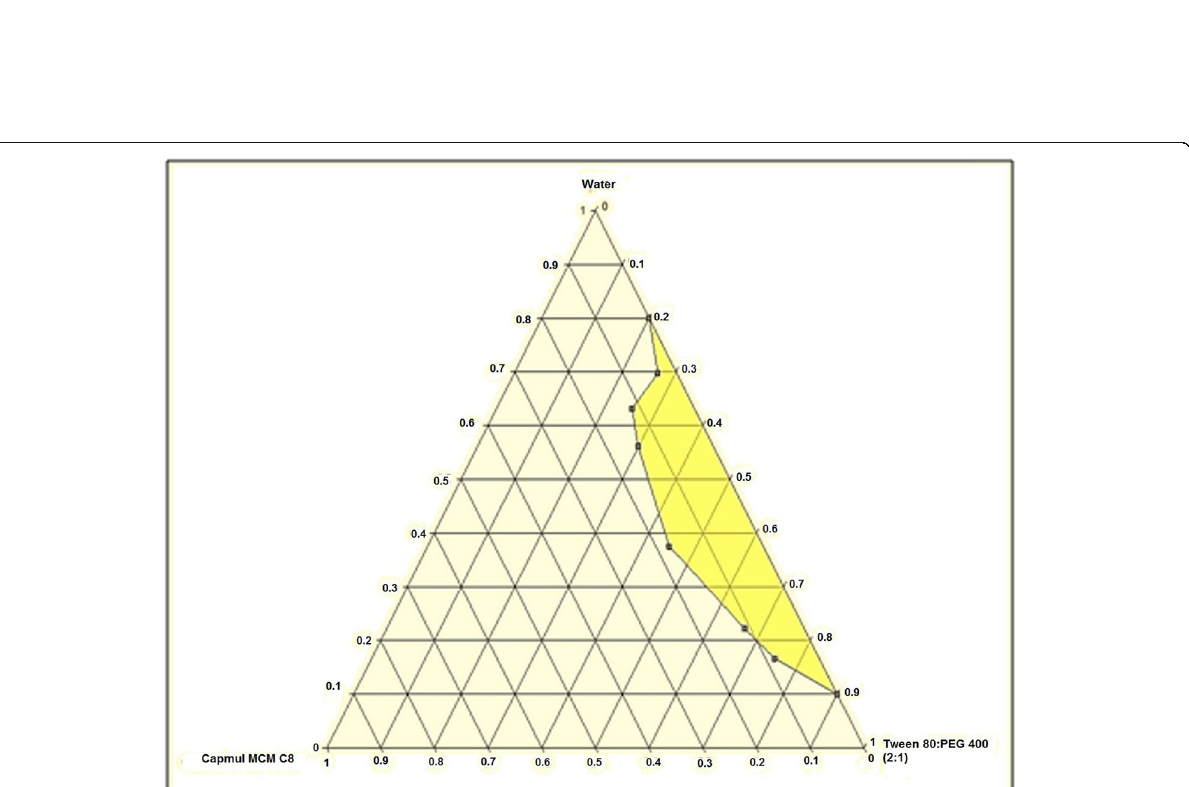
Fig. 2 Pseudoternary phase diagram showing microemulsion region containing S:CoS ratio of